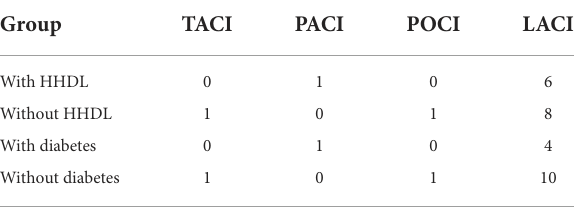
TABLE 6 OCSP classification of recurrent ischemic stroke. Group TACI PACI POCI LACI With HHDL 0 1 0 6 Without HHDL 1 0 1 8 With diabetes 0 1 0 4 Without diabetes 1